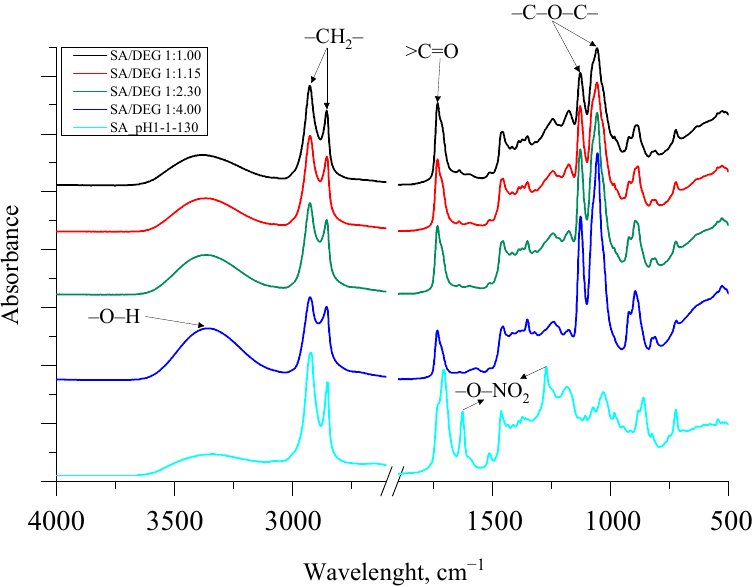
Figure 8. The FTIR spectra of the synthesized SA polyols.